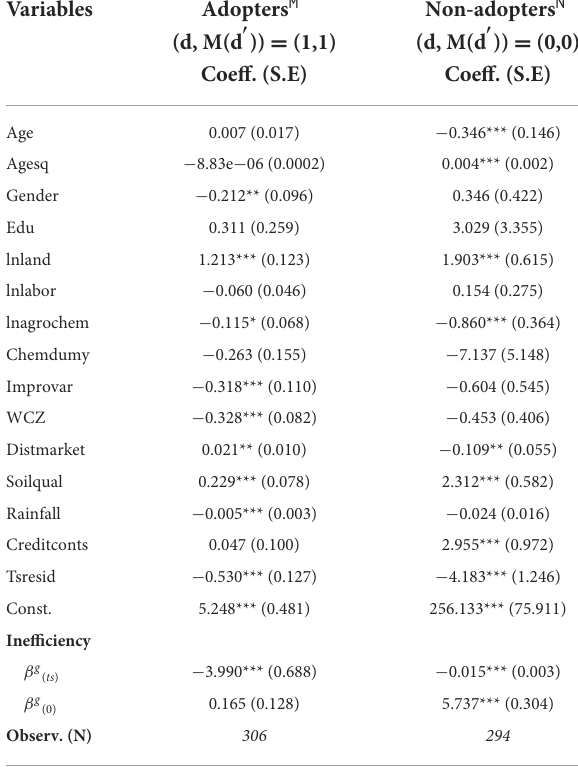
TABLE 3 Adoption without mediation—(weighted nonlinear least-squares)—yield (lnKg/Ha). Variables